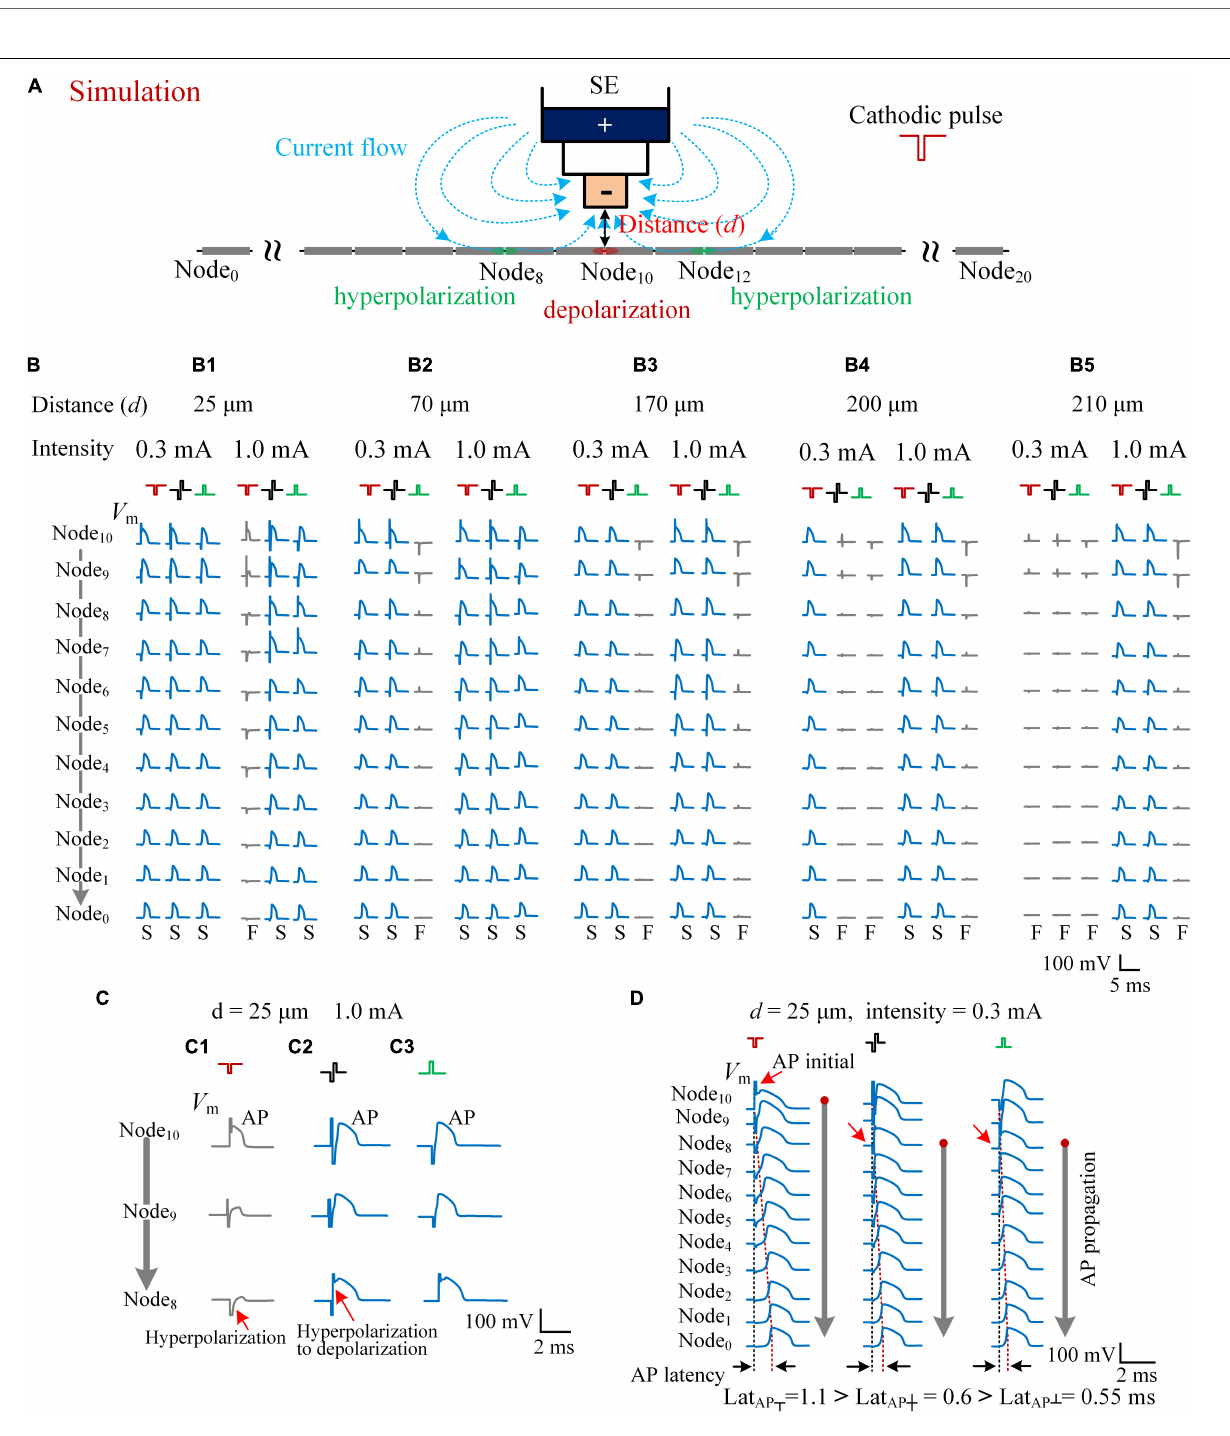
FIGURE 5 | Simulating the effects of cathodic, biphasic, and anodic pulses on axons in different distances. (A) Schematic diagram of the computational model consisting of a stimulation electrode (SE) and an axon with 21 nodes. When a cathodic pulse was applied, the current flowed from the outer pole to the inner pole of SE (denoted by blue dotted lines with arrows). The center node (Node 10 ) of the axon was depolarized, and the flanking regions (e.g., Node 8 and Node 12 ) were hyperpolarized. (B) The membrane potentials ( V m ) evoked along Node 10 –Node 0 of the five axons in different distances to SE ( d = 25, 70, 170, 200, and 210 µ m) by the three types of pulses with a pulse intensity of 0.3 and 1.0 mA. The V m waveforms in blue with a letter “S” in the bottom denote that the applied pulse successfully induced an action potential (AP), while the V m waveforms in gray with a letter “F” in the bottom denote that the applied pulse failed to induce a propagatable AP. (C) The axon in the distance 25 µ m from the SE was activated by both biphasic and anodic pulses successfully, but not by the cathodic pulse with an identical pulse intensity of 1.0 mA because of the hyperpolarization block at Node 9 and Node 8 . (D) The V m waveforms evoked along Node 10 –Node 0 of the axon, at a distance of 25 µ m, showing different initial sites (red arrows) of AP evoked by the three types of pulses with a pulse intensity of 0.3 mA. The latencies of AP (Lat AP ) are denoted in the